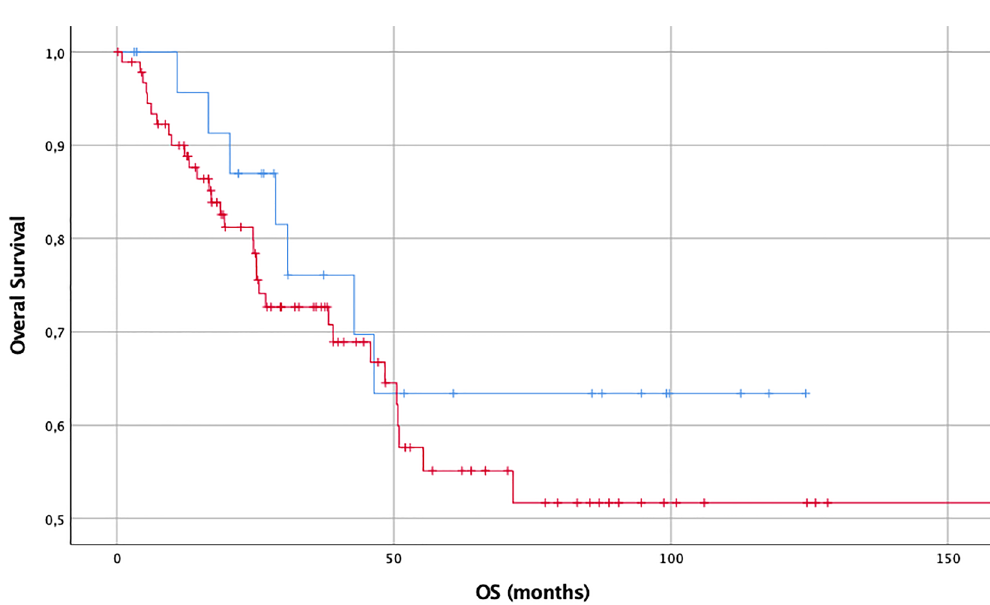
Figure 4. OS (months) in diffuse and anaplastic gliomas considering expression of Cx43: no or slight expression (blue, n = 25) versus intermediate or strong expression (red, n = 93), demonstrating no significant survival differences between these tho